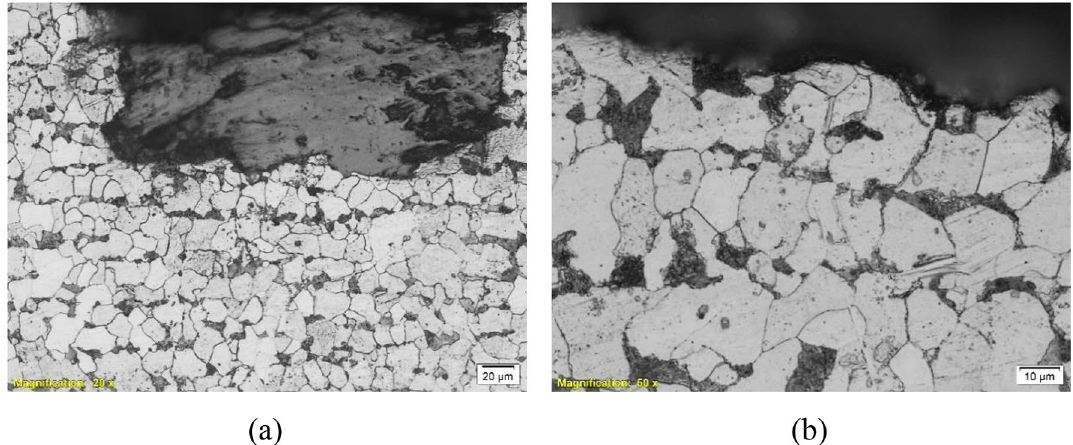
Figure 9. Microstructure of the failed pipe B7: ( a ) cross-section at the external corroded surface and ( b ) higher magnification showing typical carbon steel microstructure.